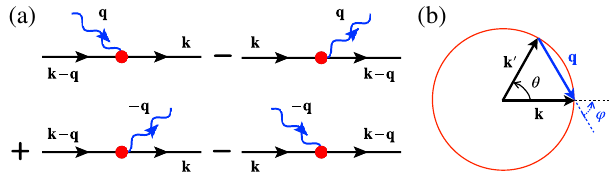
FIG. 13. (a) Schematics of different terms in the collision integral. (b) Momenta of electrons and a magnon and their mutual